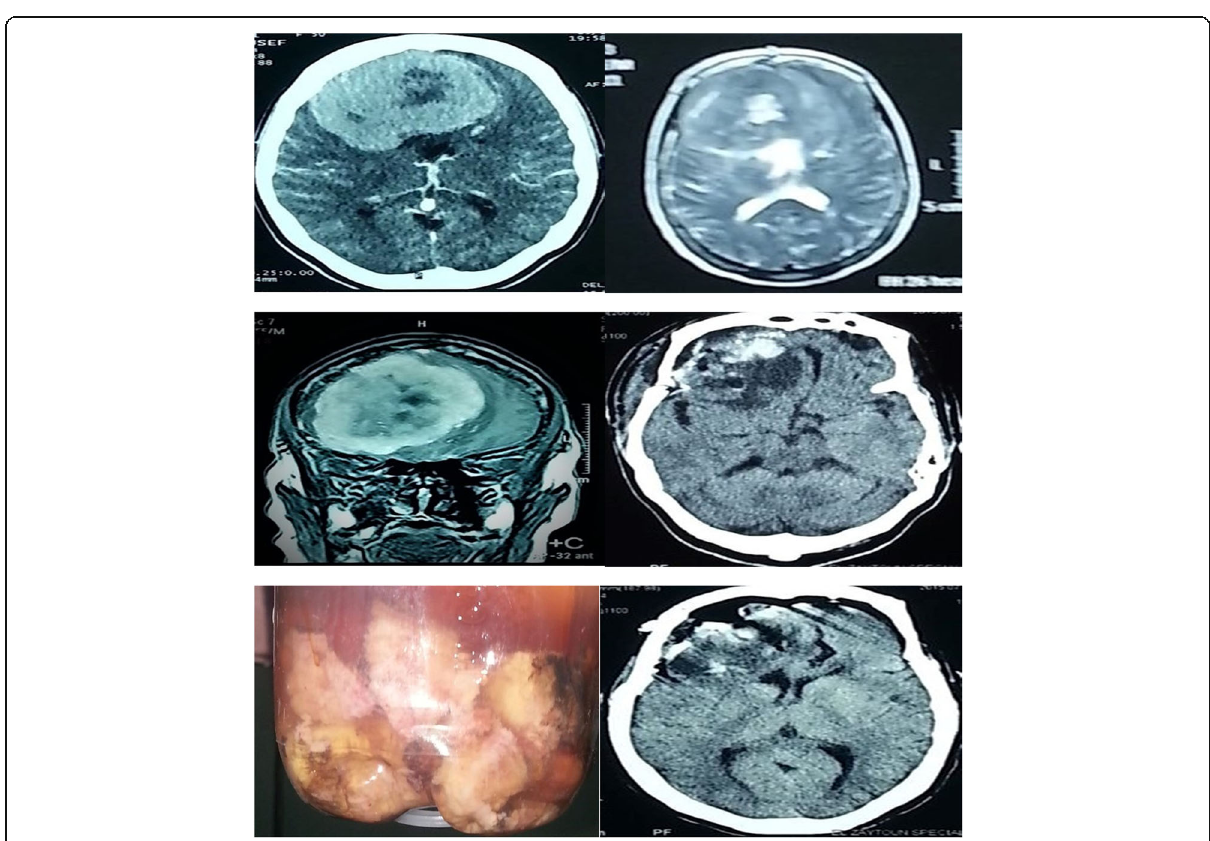
Fig. 4 Upper left, preoperative axial CT brain with contrast showing giant olfactory groove meningioma. Upper right, axial MRI T2-weighted image of the same patient. Middle left, coronal MRI with contrast of showing hyper intense lesion with heterogeneous contrast enhancement. Middle right, 1 day postoperative axial CT brain showing complete tumor removal with mild edema. Lower left, pieces of tumor after surgical removal. Lower right, 3 months postoperative CT brain after complete tumor